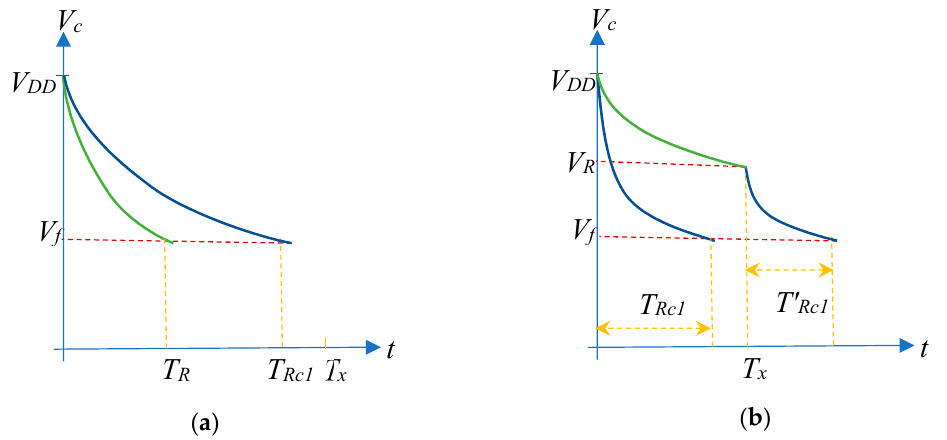
Figure 3. Evolution of capacitor voltage, V c , in discharges through R c1 (blue) and R (green). Vc(t) will vary in accordance with the comparison of the value of the discharge time through R , T R , with the constant T x . ( a ) Situation in which T R is less than T x . ( b ) Situation in which T R is greater than T x .